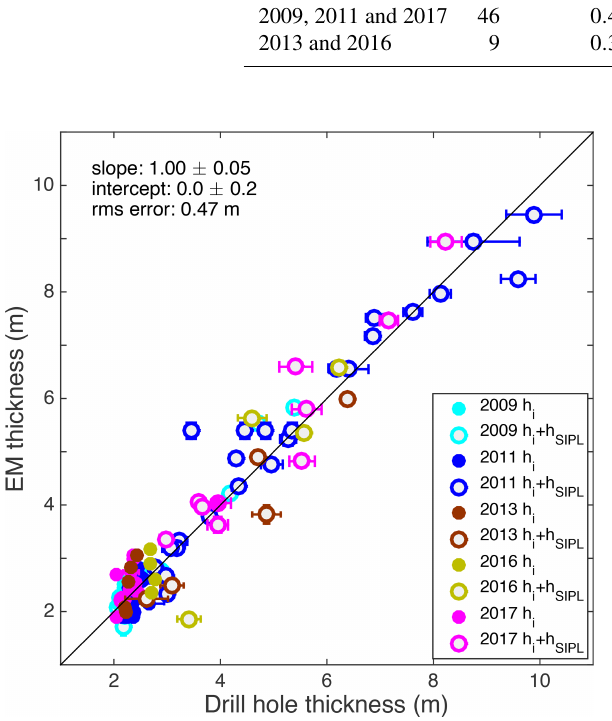
Figure 7. Scatter plot of EM derived vs. drill-hole consolidated ice thickness ( h i ; filled symbols) and total thickness ( h i + h sipl ; open symbols), with symbol colour denoting year of measurement. To- tal thickness ( h i + h silp ) was calculated with α = 0 . 4 (best fit value 0 . 40 ± 0 . 07, N = 46) for 2009, 2011, and 2017 and α = 0 . 3 for 2013 and 2016 (best fit value 0 . 30 ± 0 . 15, N = 9); see Table 1. Error bars show ice thickness variability at each calibration location (five drill holes) or within the approximate EM footprint (the latter are too small to be visible at the scale of the graph). The black line is 1 : 1. N = 9 for 2009, N = 26 for 2011, N = 5 for 2013, N = 4 for 2016, and N = 11 for 2017; thus total N = 55.